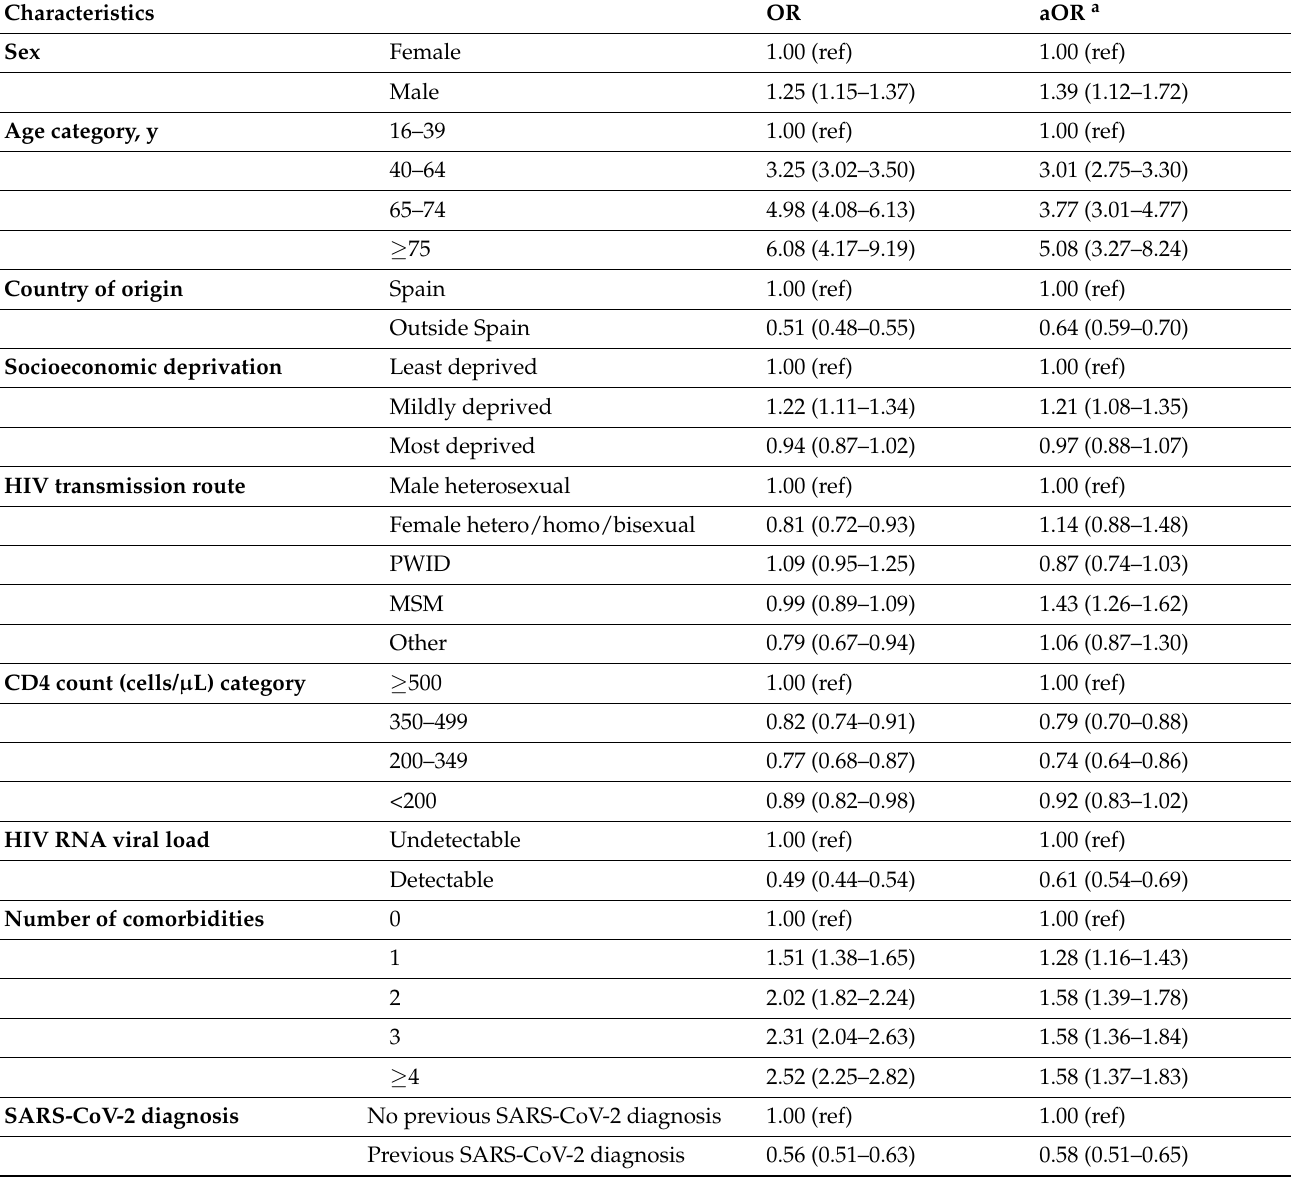
Table 2. Factors associated with SARS-CoV-2 vaccine coverage among people living with HIV in Catalonia in multivariable logistic